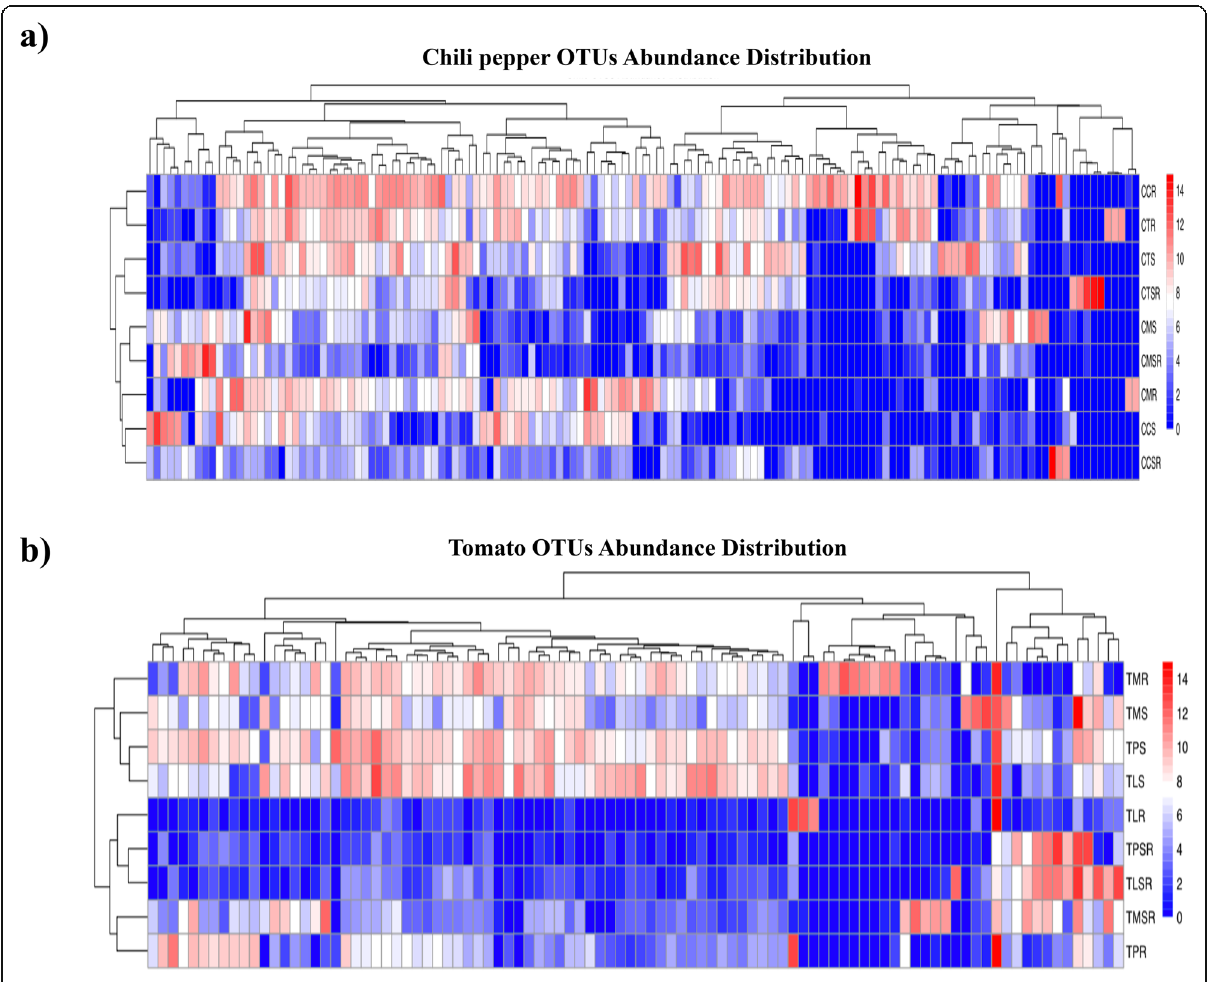
Fig. 3 Distribution analysis of the abundance of the OTUs found in a C. annuum and b S.